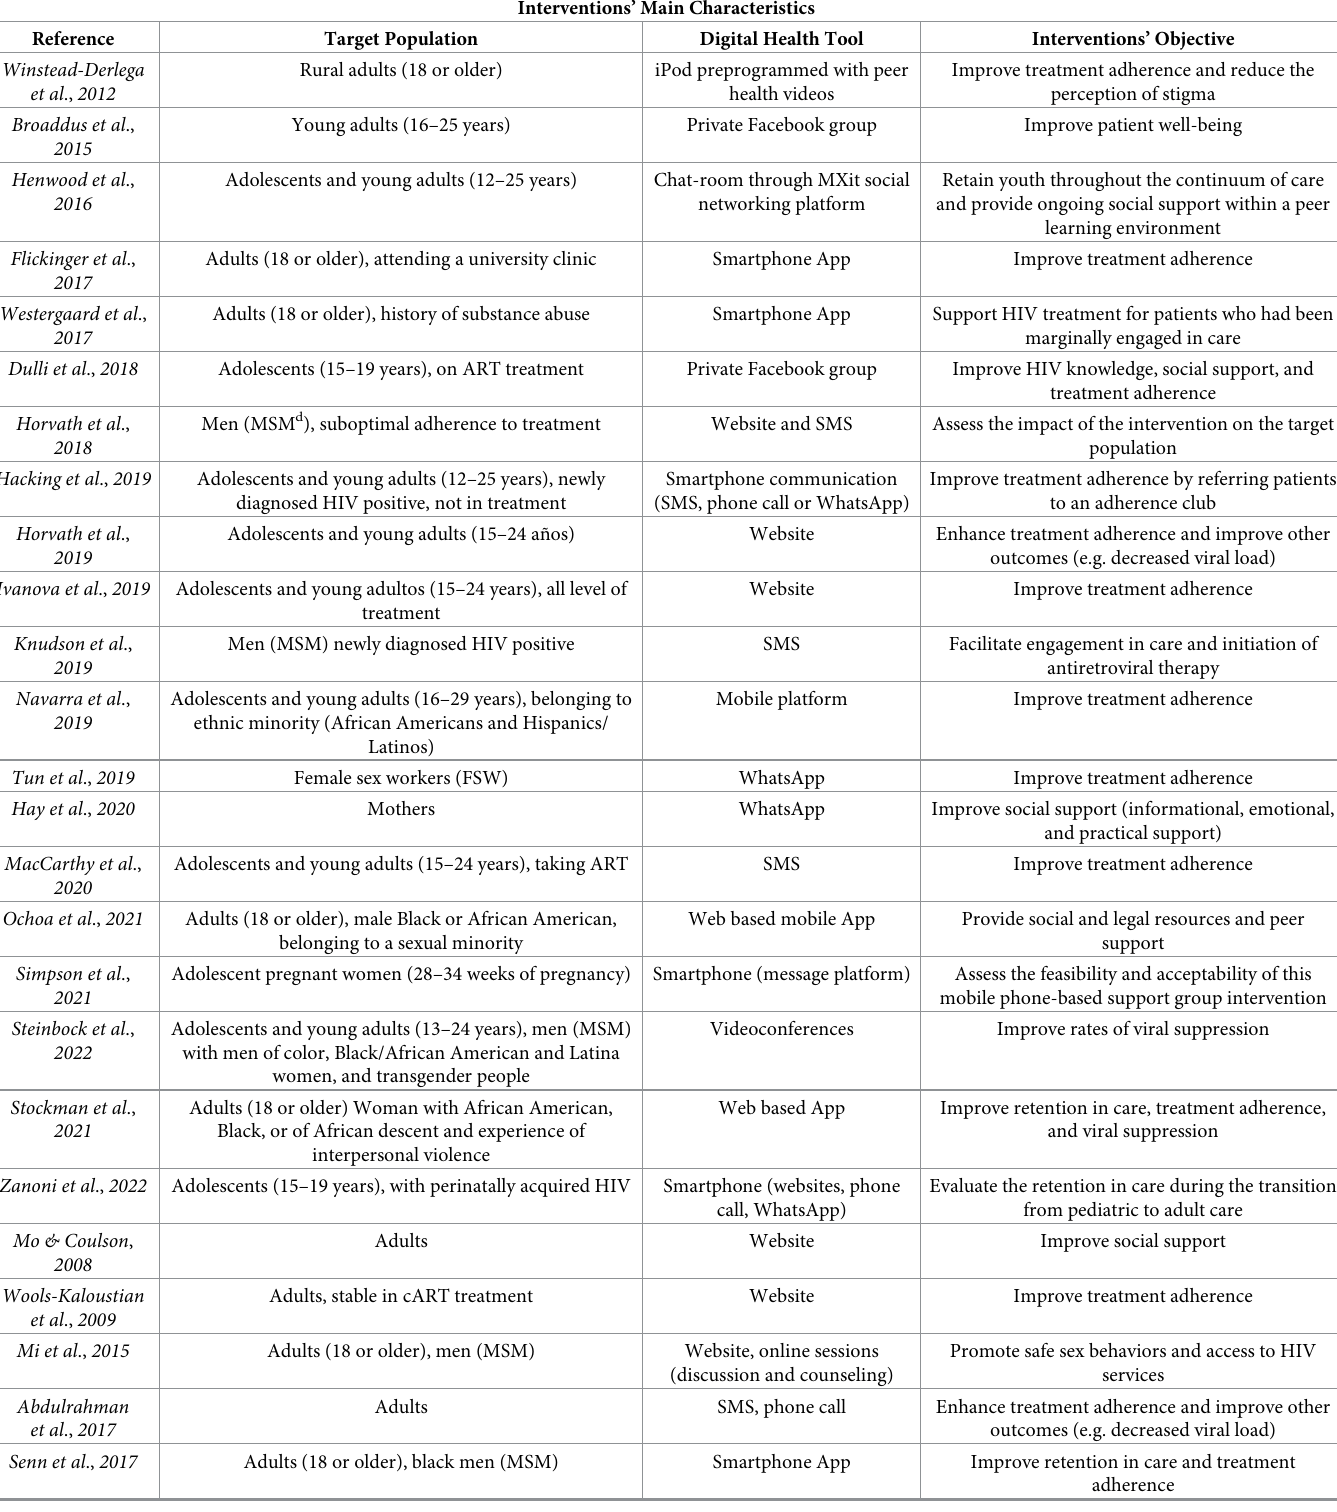
Table 3. Main characteristics of the included